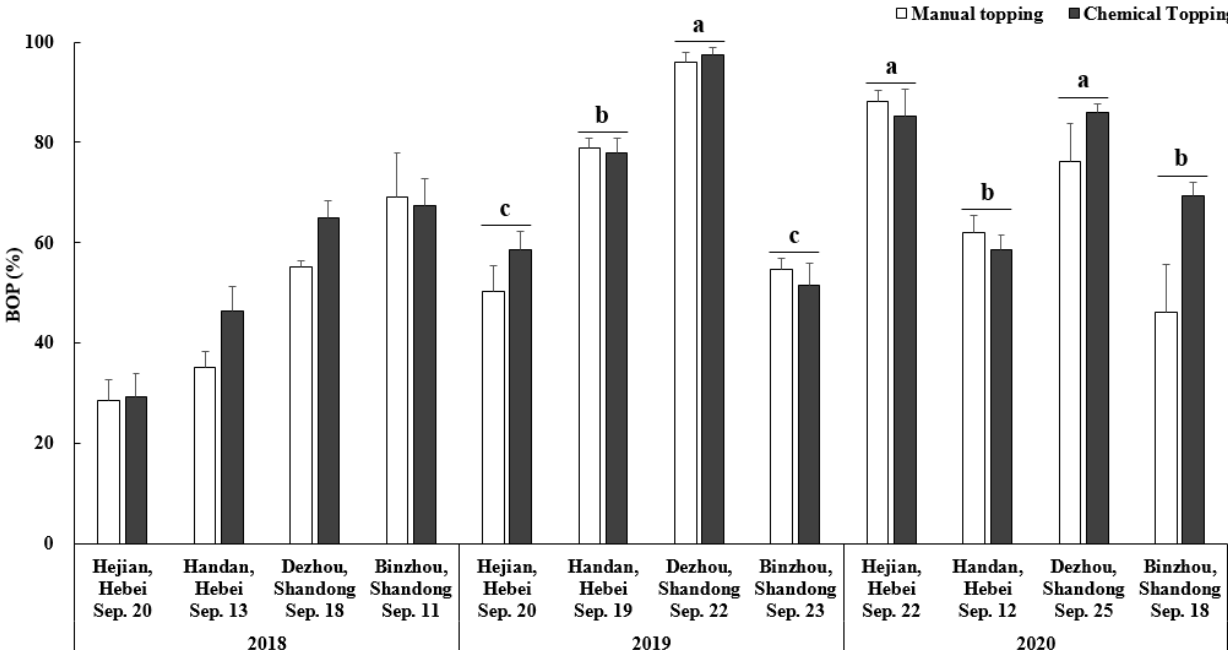
Figure 6. Effect of topping treatments during flowering period on boll opening percentage (BOP) in mid- or late September; t -tests were used to compare the means of manual topping and chemical topping at the 0.05 probability level. Different letters indicate significant differences among locations within the year according to least significant difference at the 0.05 probability level.